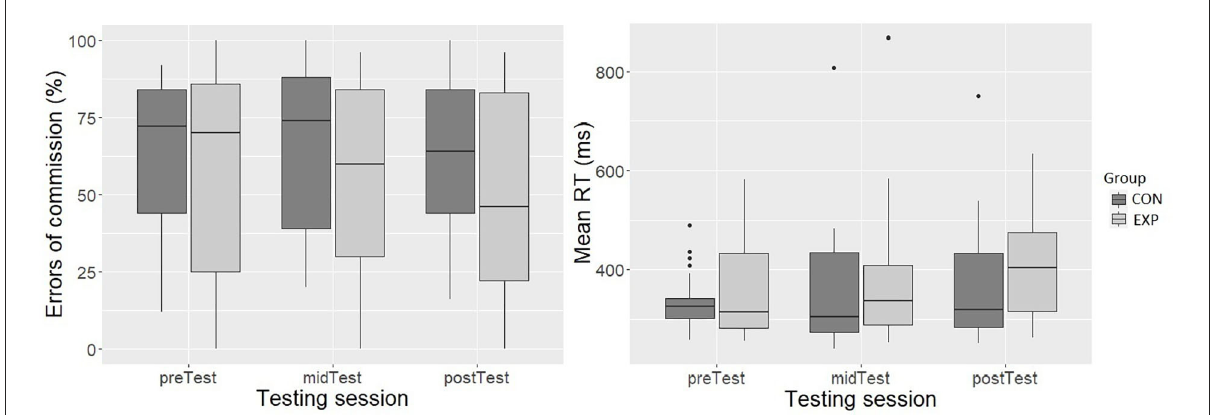
FIGURE3 The error of commissions (%) (y-axis; left-side graph) and mean RTs (ms) (y-axis; right-side graph) during the SART testing sessions (x-axis; both graphs). The box depicts 50 % of all values (IQR). The top 25% and bottom 25% of all values are excluded from the box. The top and bottom of the whiskers are the minimum and maximum, excluding outliers (outliers defined 1.5 x IQR). The horizontal line inside the box represents the median value.